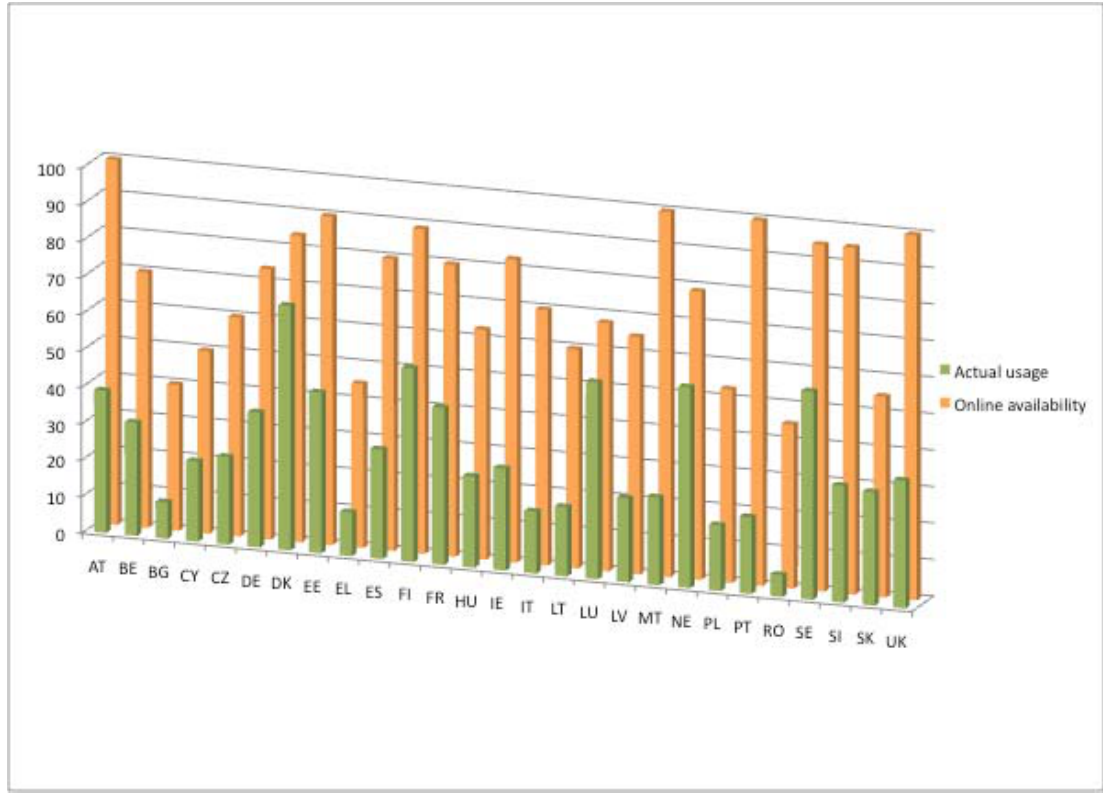
Figure 1: Use of eGovernment services compared to front office availability, EU27 countries, 2009